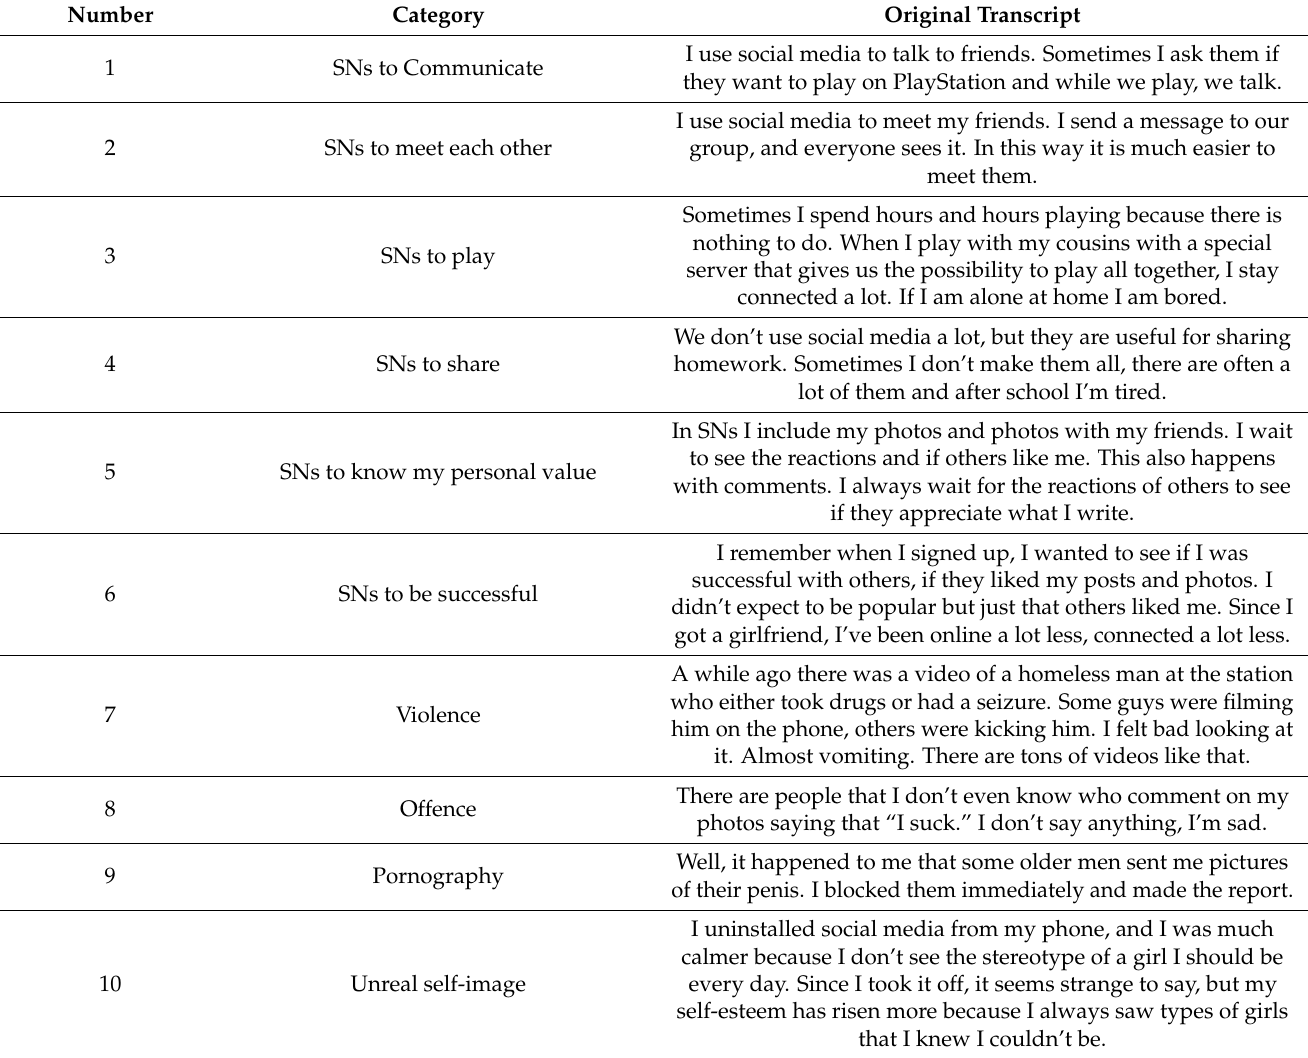
Table 1. Examples of the open coding